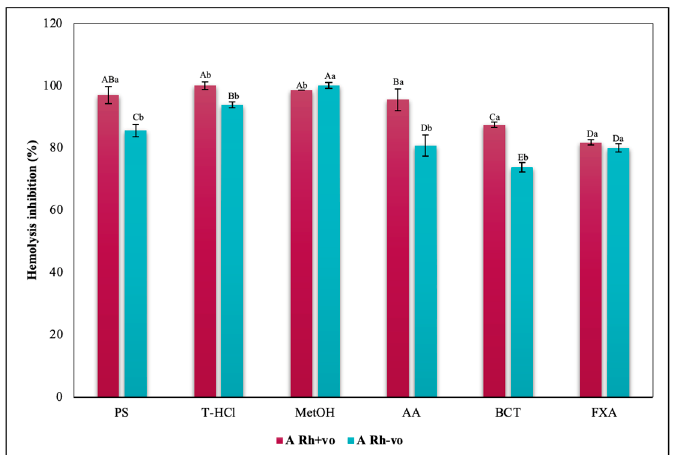
Figure 10. Inhibitory effect of hypotonicity-induced hemolysis of P. cruentum extracts on human erythrocytes with different RhD (positive and negative) of A blood group. Different letters represent significant differences in the means between treatments and groups ( p ≤ 0.001). Capital letters represent a two-way ANOVA. Lowercase letters represent a univariate ANOVA between the extracts. PS, extract of physiological solution; T-HCl, 0.5 M Tris-HCl extract; MetOH, 99% methanol extract.